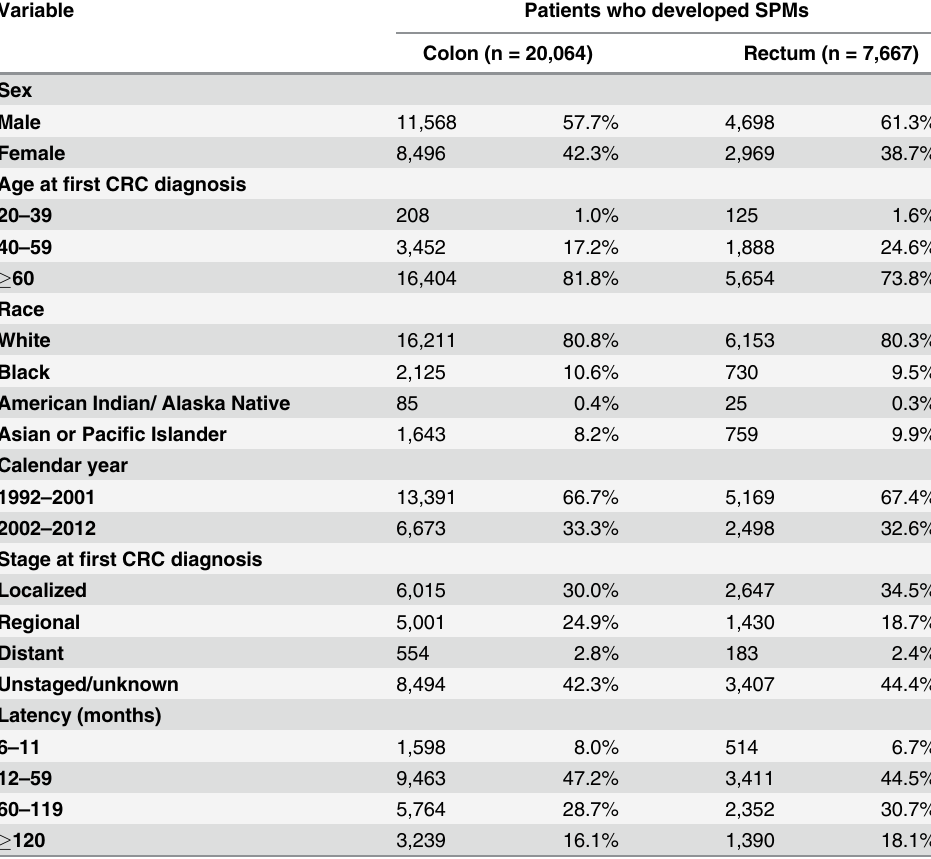
Table 1. Variables of CC and RC patients who developed